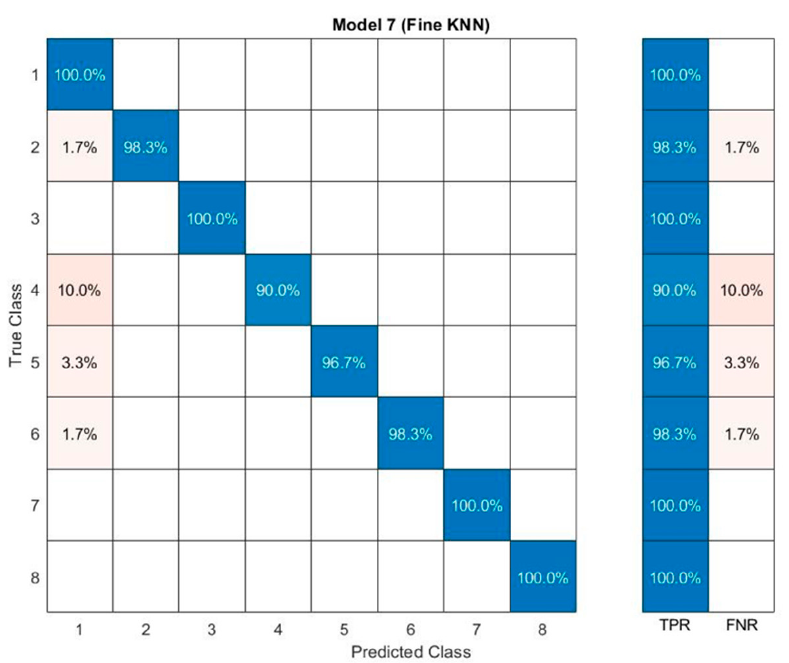
Figure 12. Quadratic SVM confusion matrices.